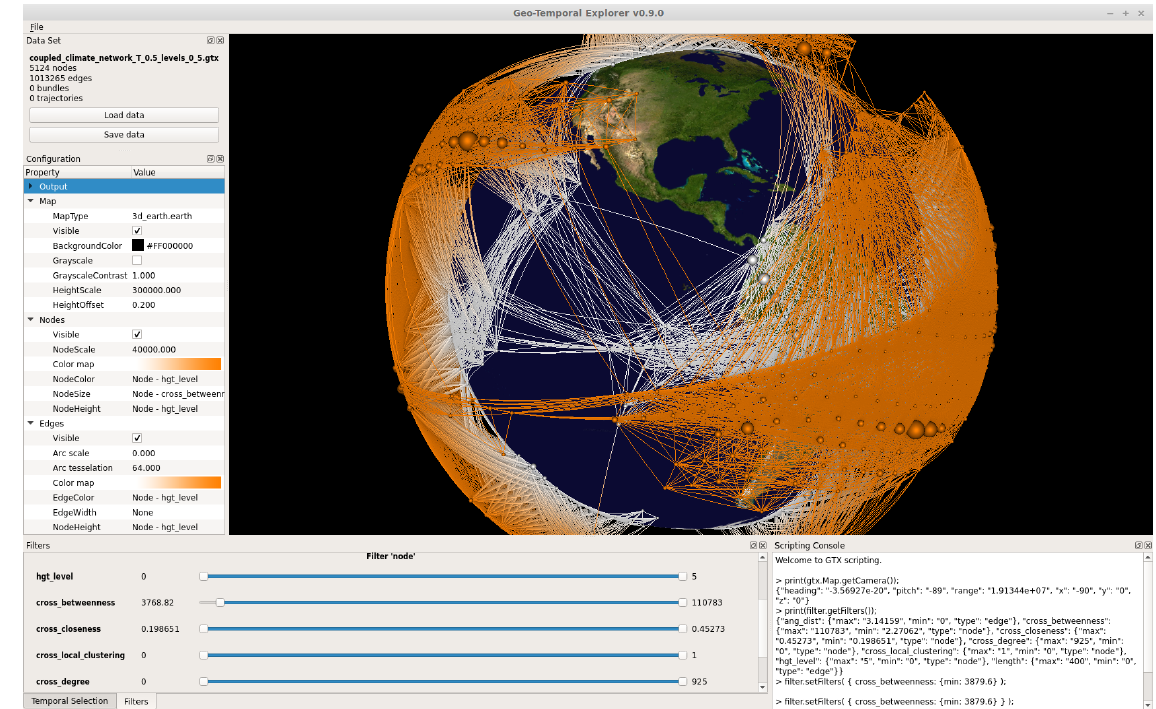
Figure 14. GTX screenshot showing 3-D network visualisation, mapping configuration, interactive filtering, and scripting